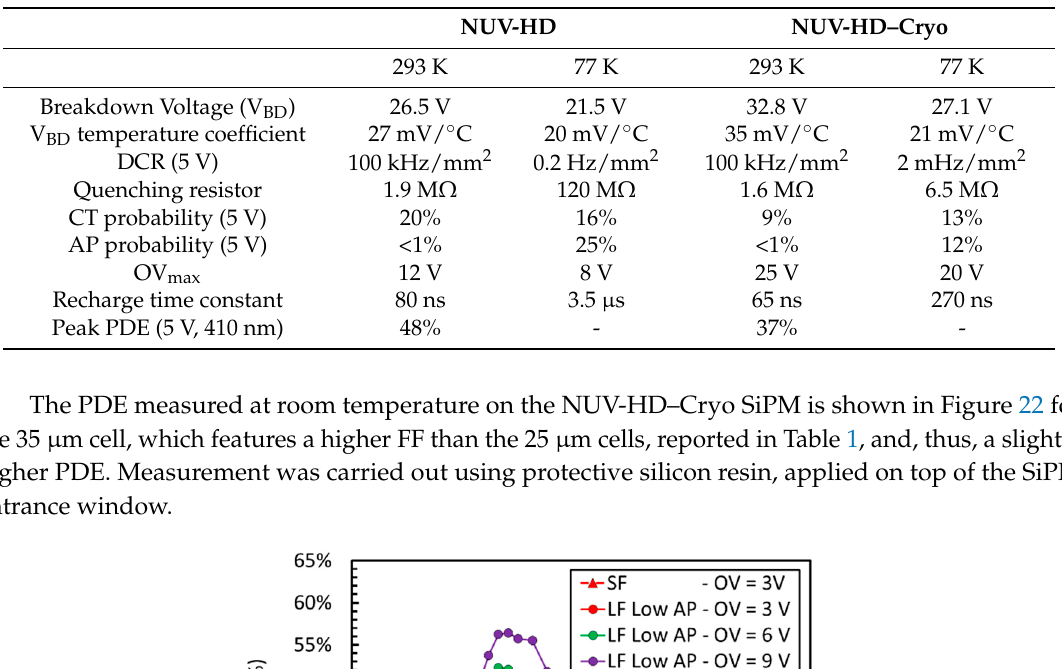
Table 1. Comparison of the main features of NUV-HD and NUV-HD – Cryo technologies, 25 µm cell size.